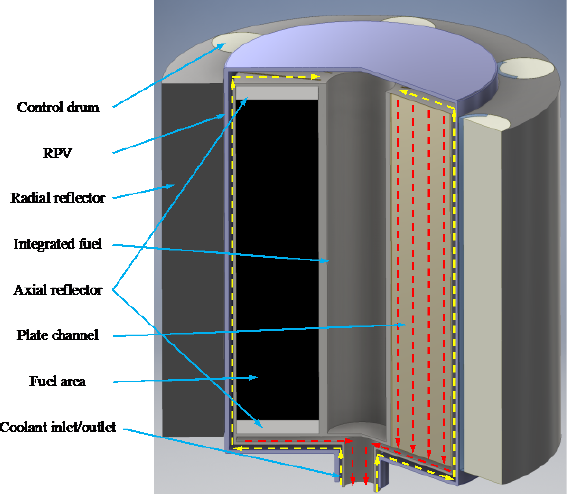
Figure 2. 3-dimension view and the coolant flow of the IGCR-200 reactor.